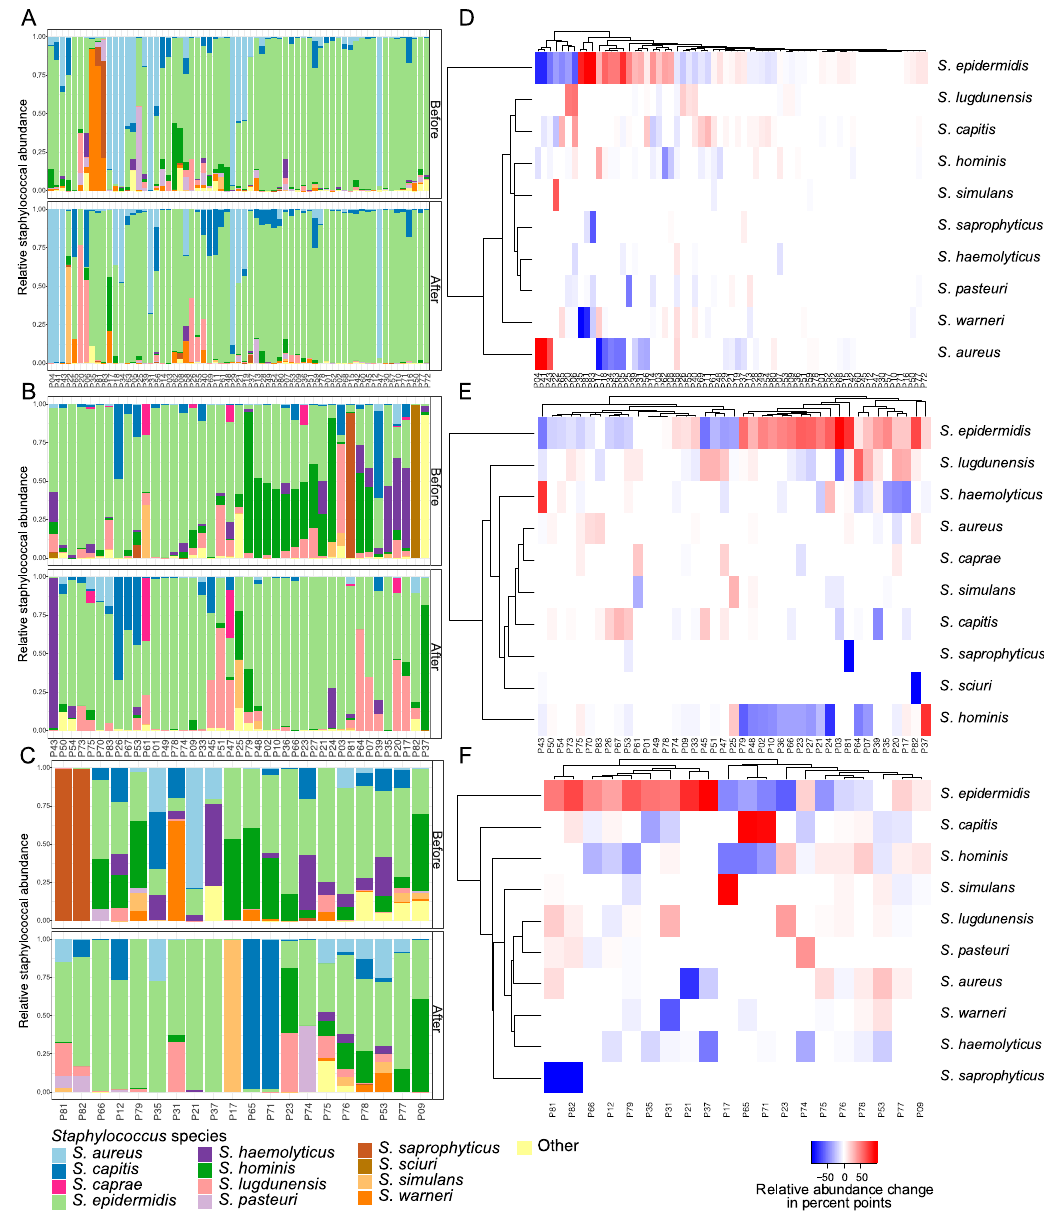
Figure 3. Staphylococcal communities from arthroplasty patients sampled before and after decolonisation treatment and arthroplasty surgery. Bar plots showing alterations in the 10 most abundant Staphylococcus species present in ( A ) nares of 65 patients, ( B ) groin of 41 patients, and ( C ) operation site of 20 patients, assessed by tuf gene sequencing. Heatmaps show patient-wise relative alterations in percentage points of the 10 most abundant Staphylococcus species from ( D ) nares, ( E ) groin, and ( F ) operation site from before compared to after decolonisation treatment and arthroplasty surgery. Patients are clustered according to similarities in relative abundance alterations. For